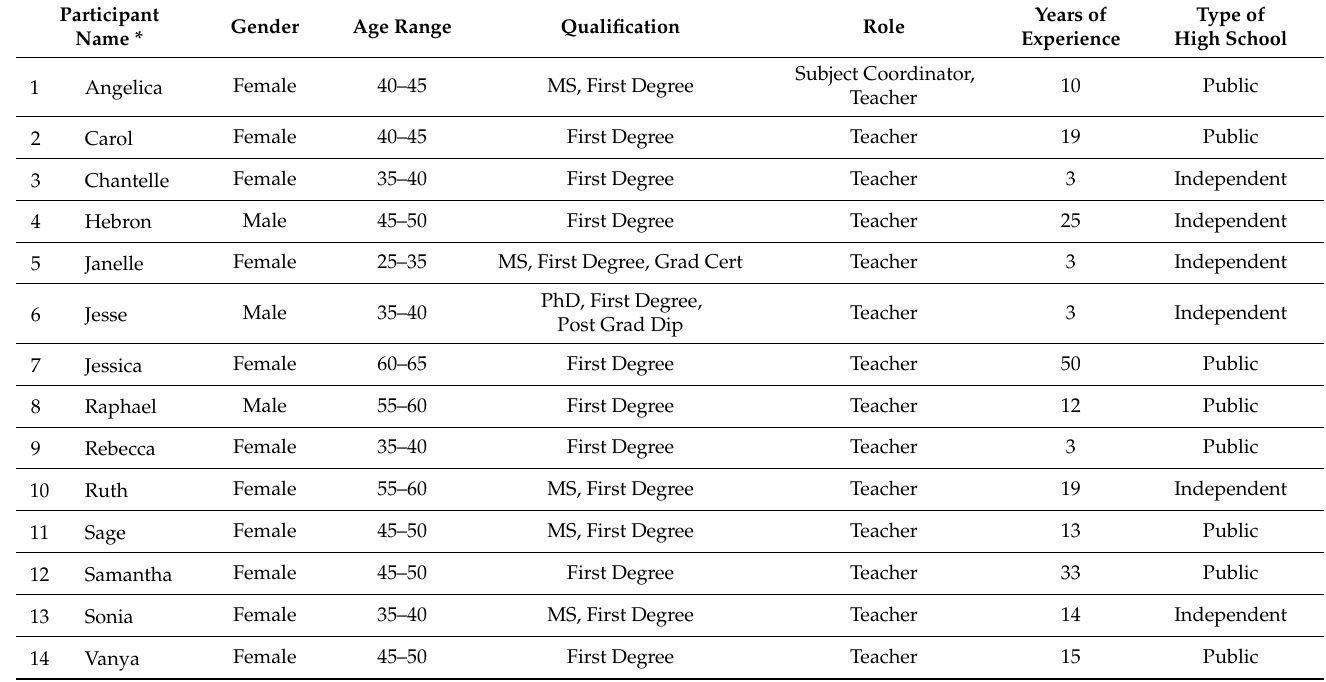
Table 4. Demographic profile of participants for the qualitative phase of the study ( n =